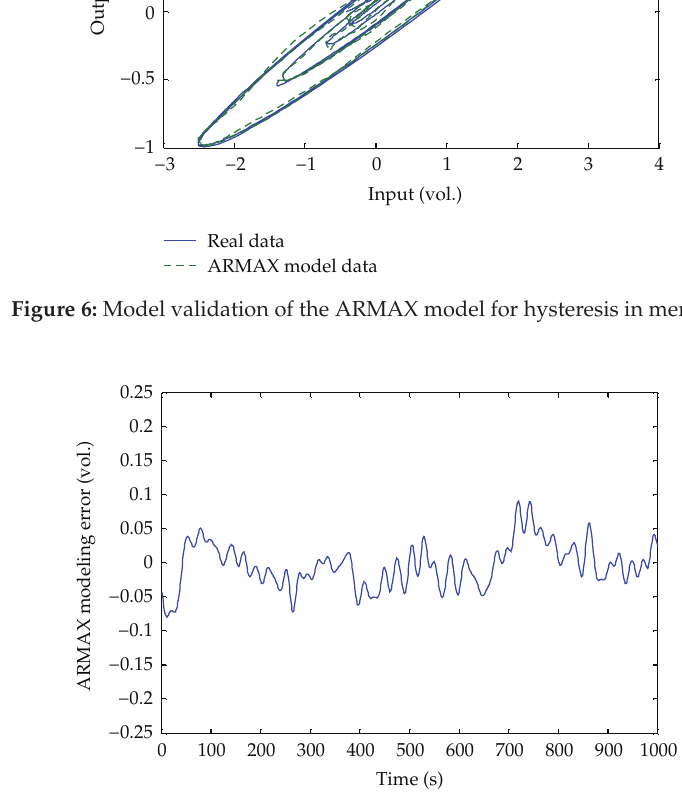
Figure 7: The modeling error of the ARMAX hysteretic